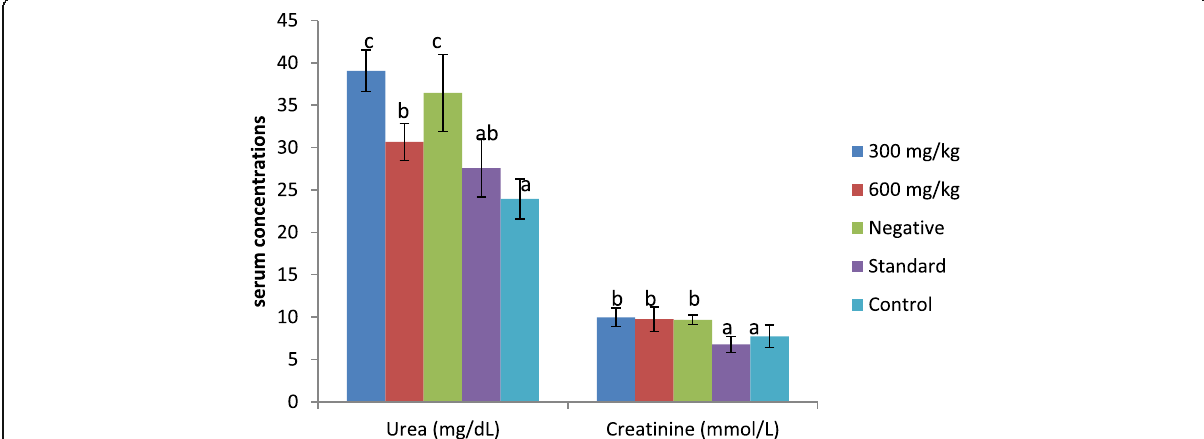
Fig. 6 Effect of Methanol Root Extract of Chromolaena odorata on Serum Urea and Creatinine in Alloxan Induced Diabetic Rats. Each bars represents Mean ± SEM of triplicate determinations. Bars with different alphabets indicate significant difference at ( p <